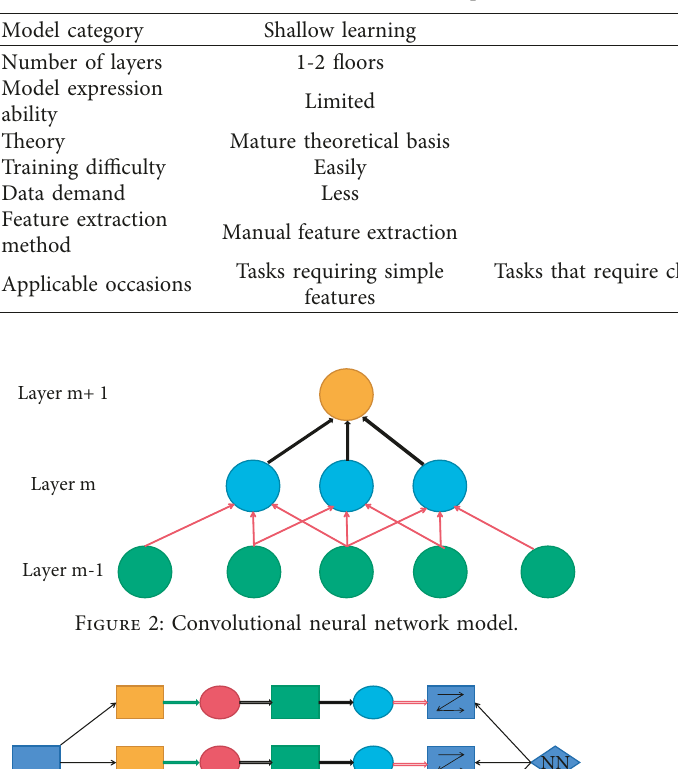
Table 1: Comparison of shallow learning and deep learning.